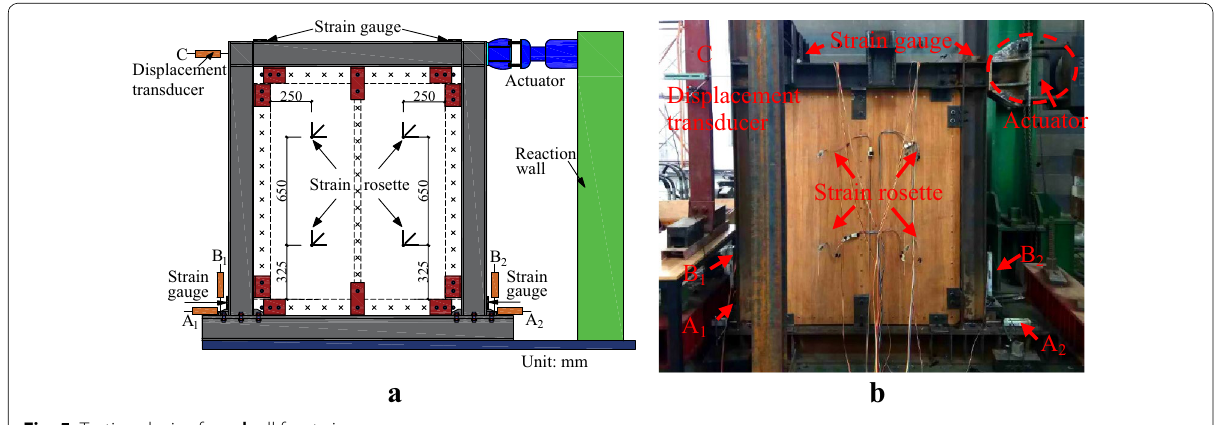
Fig. 5 Testing device for a , b all front